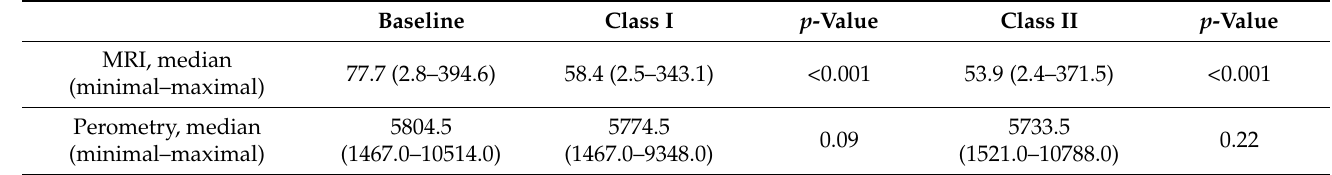
Table 2. Volume of venous malformations assessed with MRI and volume of the affected extremity assessed with perometry. Measurements were performed at baseline (without compression) and during wearing compression stockings of class I or class II. p -values represent the comparison of class I and class II to baseline values.